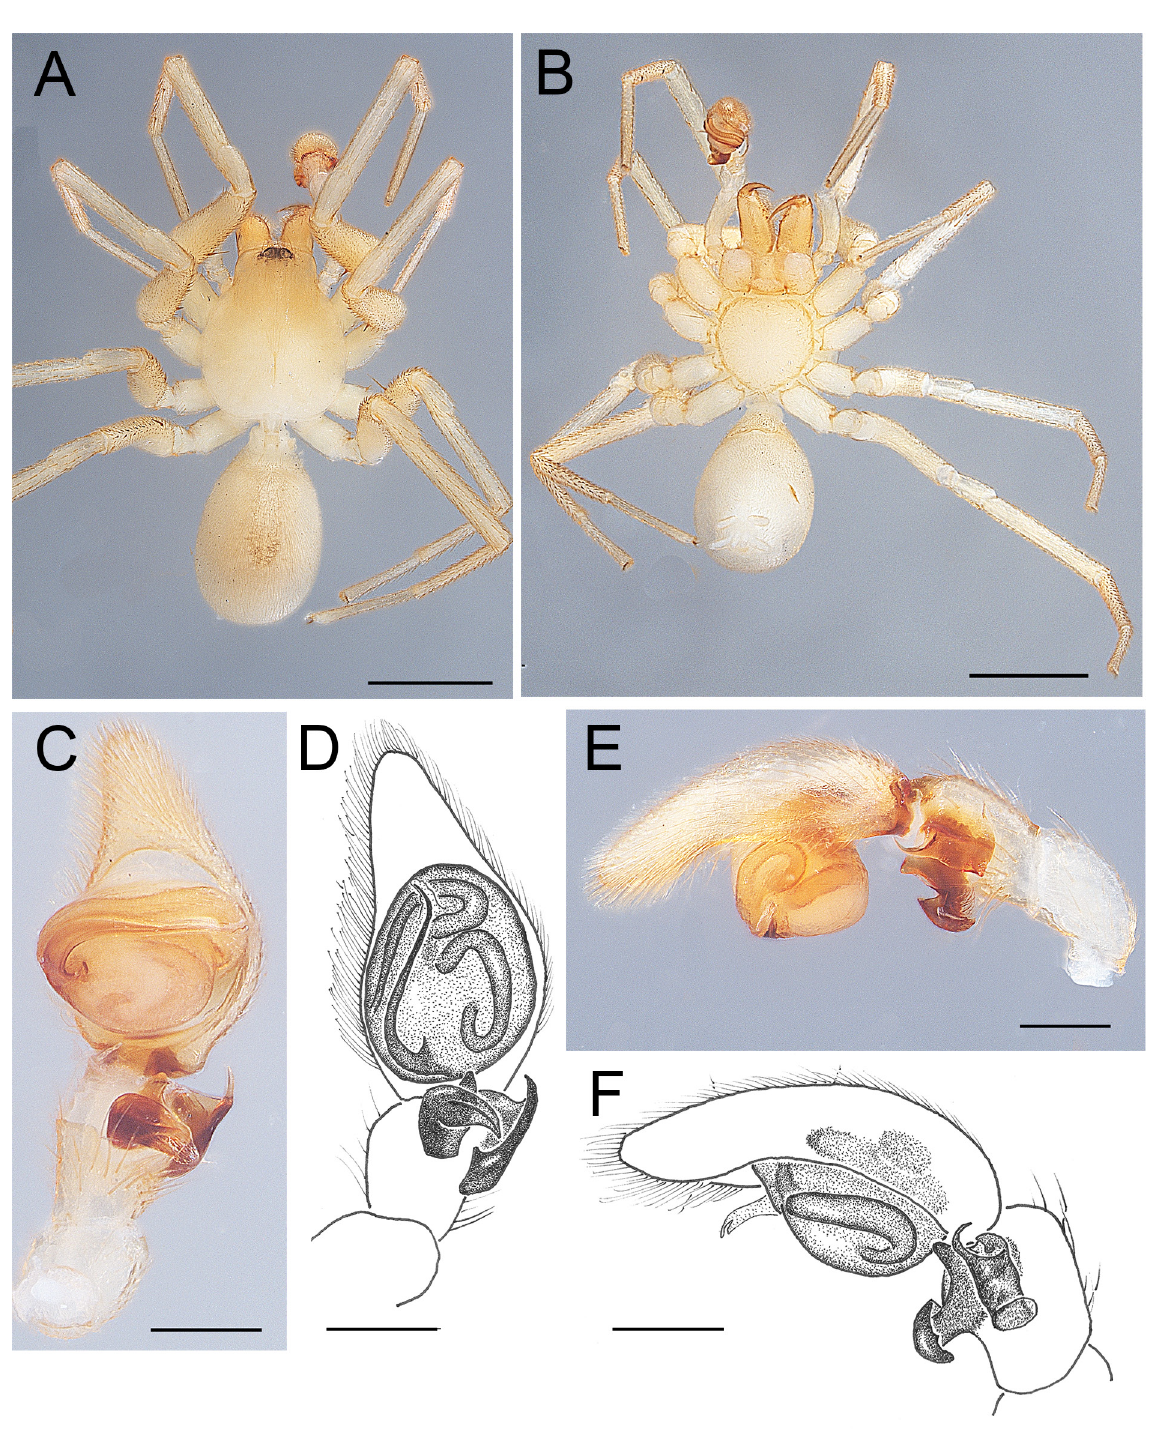
Fig. 15. Andromma delphiurum sp. nov. A–B, C, E . ♂, paratype (BE_RMCA_ARA.Ara 247537), D, F . ♂, holotype (BE_RMCA_ARA.Ara 235830). A . Habitus, dorsal view. B . Same, ventral